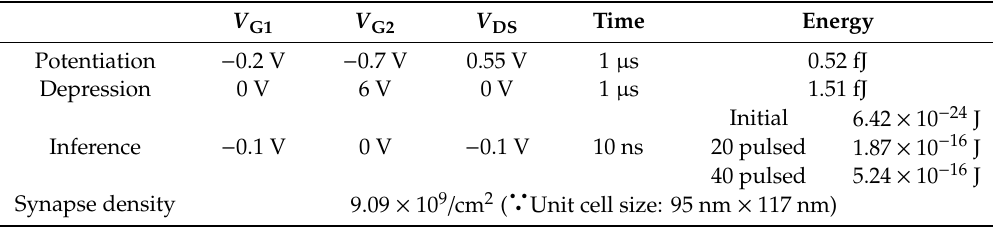
Table 2. Energy consumption per realizable synaptic event and the calculated synapse density.